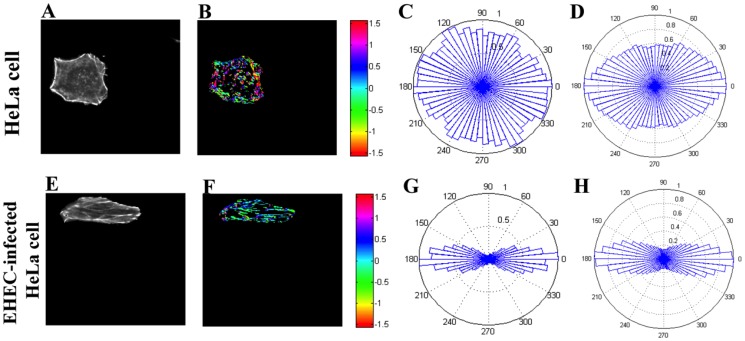
The F-actin orientation in the basal region of HeLa cells (A to D) without, and (E to H) with EHEC infection.Cells fixed and stained with FITC-phalloidin (green) for F-actin, imaged in HeLa cells (A) without, (E) with EHEC infection. In (B) and (F), the images of actin fibers with fluorescence intensity above a selected threshold are marked and color-coded to represent their angular orientation in radians (1 radian≈57.3 degrees). The direction along the principal axis (i.e., the direction along which the maximum number of actin filaments were aligned) is denoted as 0; (B) without, and (F) with EHEC infection. The angular plots corresponding to (B) and (F) are shown respectively in panels (C) and (G), in degrees. Similar data compiled from from 15 cells are shown in (D) and (H), respectively. The orientation distributions without and with EHEC infection are statistically significant (p<0.001, Watson's U2 test). Variance and Kurtosis of the angular distributions are given in Table 1.